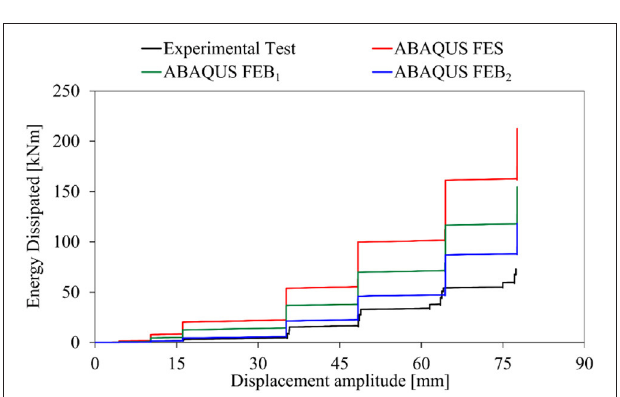
FIGURE 12 | Cumulative dissipated energy obtained for experimental test and numerical models.